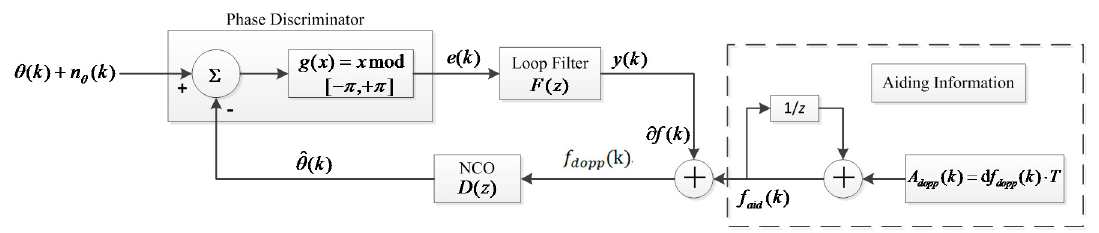
Figure 2. Structure of delta Doppler-aided PLL in discrete-time domain.